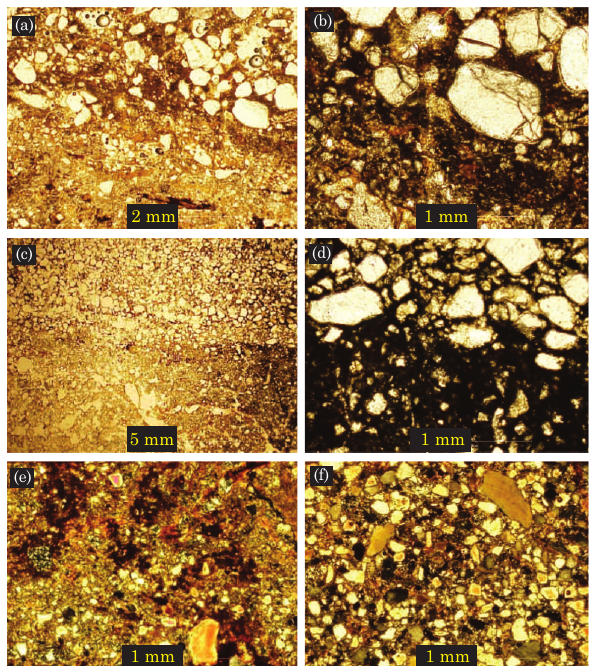
Figure 4. Photomicrograph of profiles AP1 (a and b: 78-88 cm), AP4 (c and d: 143-153 cm) and AP10 (e and f: 148-157 cm) that show coarse over finer sediments, evidencing the abrupt texture